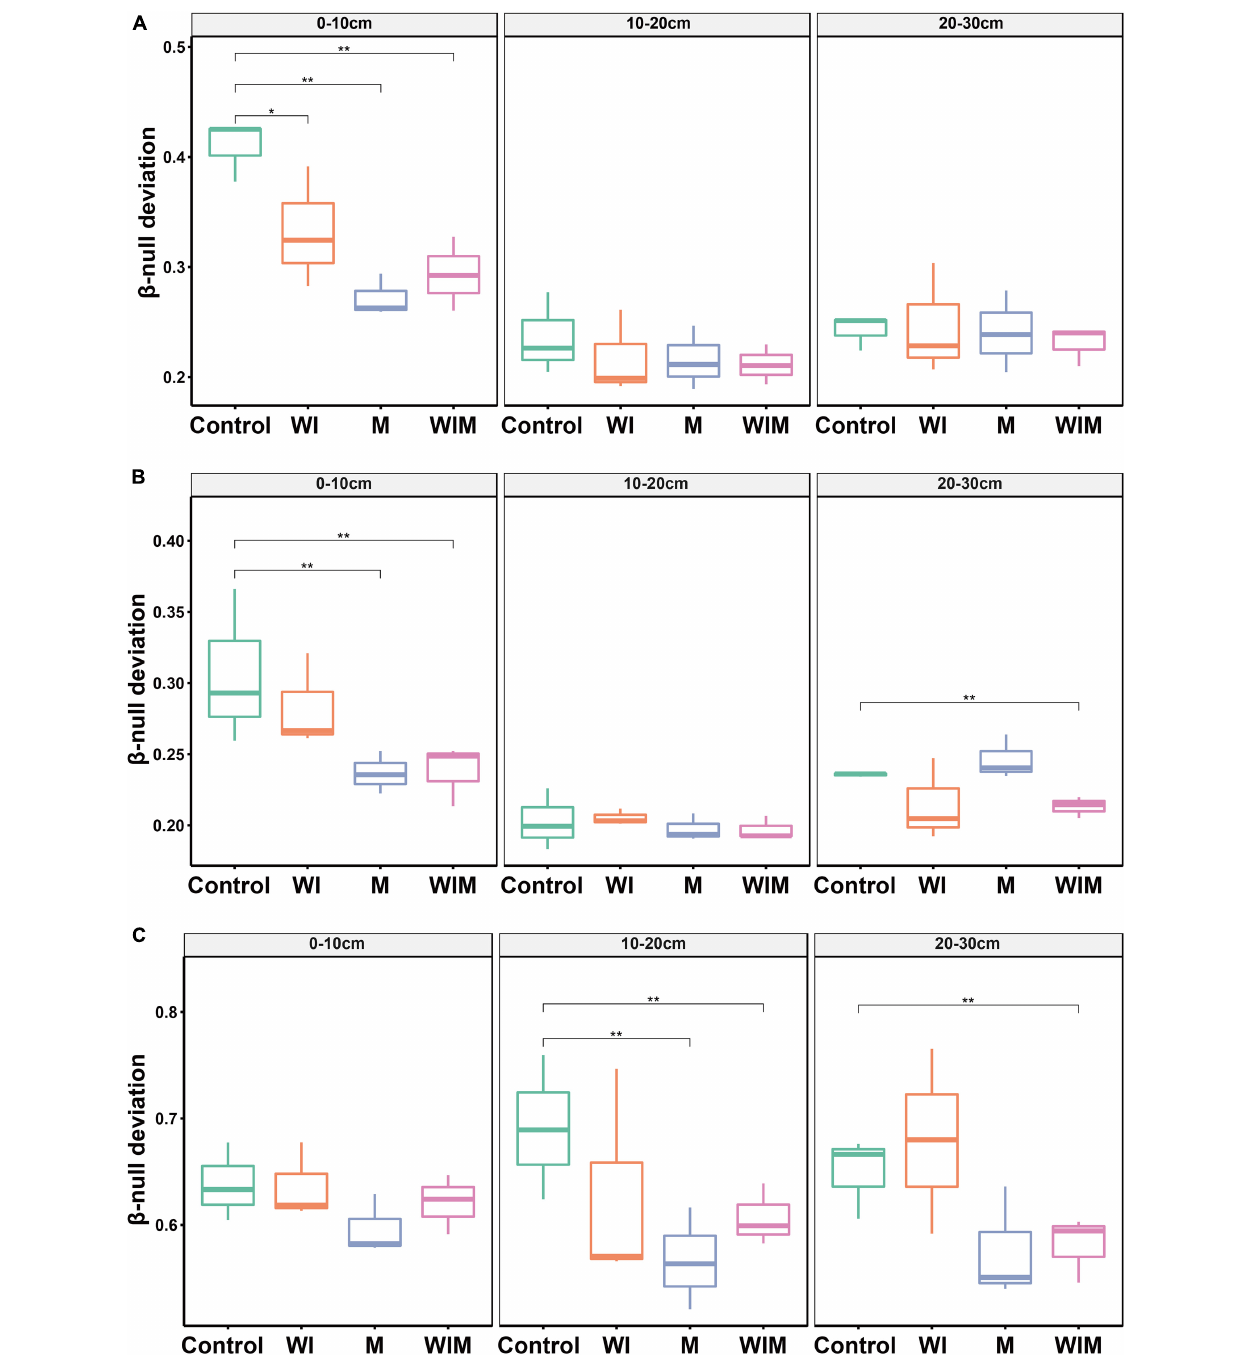
FIGURE 4 | Abundance-based β -null deviation for archaeal (A) , bacterial (B) , and fungal (C) communities based on Bray–Curtis distance. * Indicates a significant difference between treatments as determined by Kruskal–Wallis rank sum test (* P < 0.05; ** P < 0.01). WI, freezing saline water irrigation; M, plastic mulching; WIM, WI +